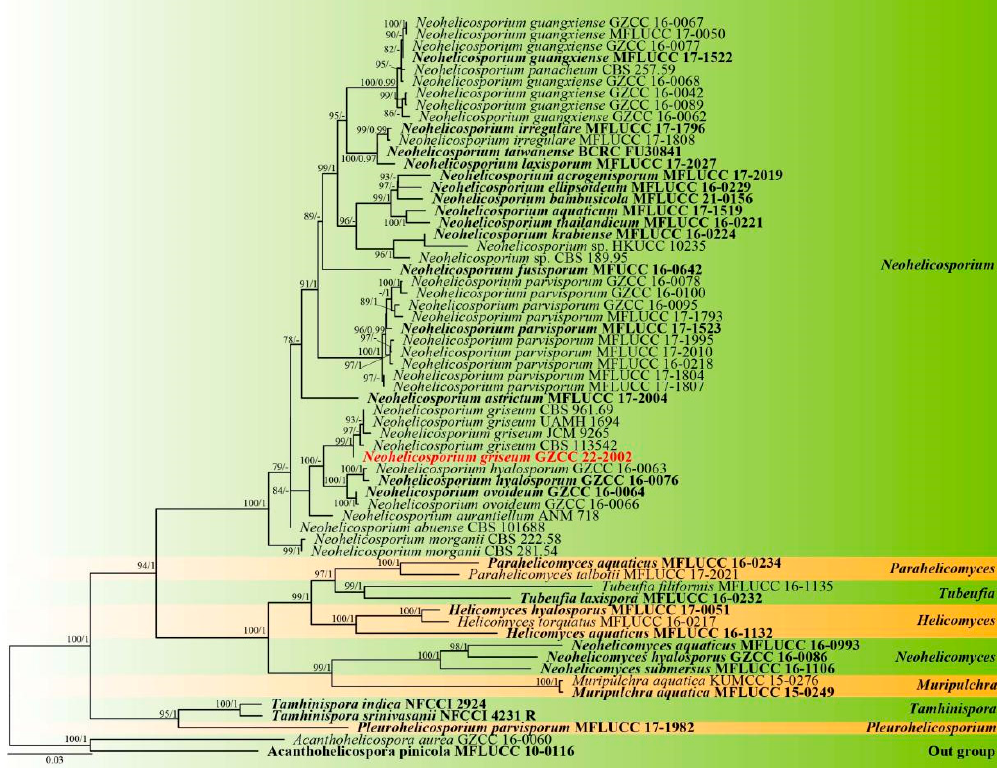
Figure 2. Phylogenetic tree generated from IQ-Tree v.2 analysis based on analysis of a combined set of LSU, ITS, TEF1 α , and RPB2 sequence data. Bootstrap support values of maximum likelihood (ML) equal to or greater than 75% and Bayesian posterior probabilities (PP) equal to or greater than 0.95 are given near the nodes as ML/PP. Acanthohelicospora aurea (GZCC 16-0060) and A. pinicola (MFLUCC 10-0116) were used as outgroup taxa. The newly generated sequence is indicated in bold red.